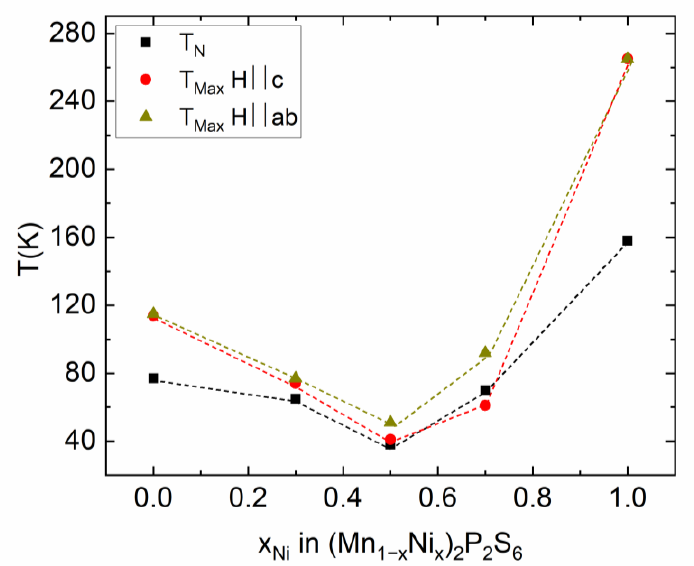
Figure 8. Evolution of T N and T max as a function Ni substitution for (Mn 1−x Ni x ) 2 P 2 S 6 single crystals.